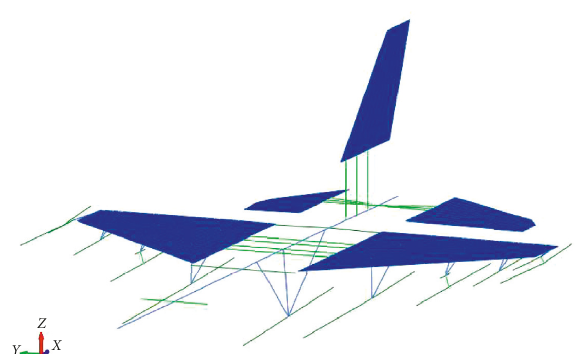
Figure 7: FE model with external loads.